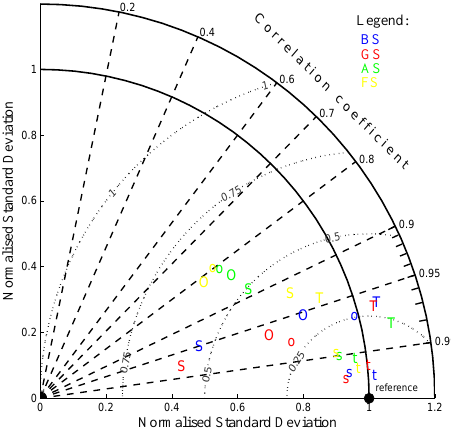
Fig. 3. Taylor diagram comparing T , S and O calculated by the use of BED for T / S relaxation (comparison points are denoted with small letters) and 3-D model values for T / S relaxation (denoted with capital letters). The pattern statistics of T , S and O are nor- malised by the standard deviation of the corresponding observation field. Different letter colour in the diagram refers to a particular station: BS – blue; GS – red, AS - green; FS –